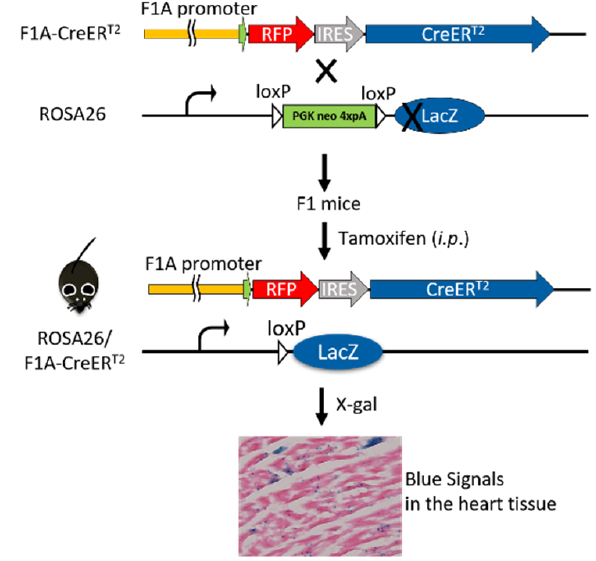
Figure 3. Breeding of F1A-CreER T2 × ROSA26 F1 mice. The F1A-CreER T2 transgenic mice were crossed to LacZ reporter mouse line, ROSA26, and the double-positive F1 mice were chosen for protein expression analysis. After tamoxifen treatment, the CreER T2 recombinase-estrogen receptor fusion protein, which is driven by tissue-specific promoter, F1A, will bind to tamoxifen and translocate into nucleus to recombine its loxP-flanked DNA targets, remove the transcriptional termination poly A cassette and produce β -galactosidase. The activity of β -galactosidase could be detected by staining tissues with X-Gal and showing punctate blue